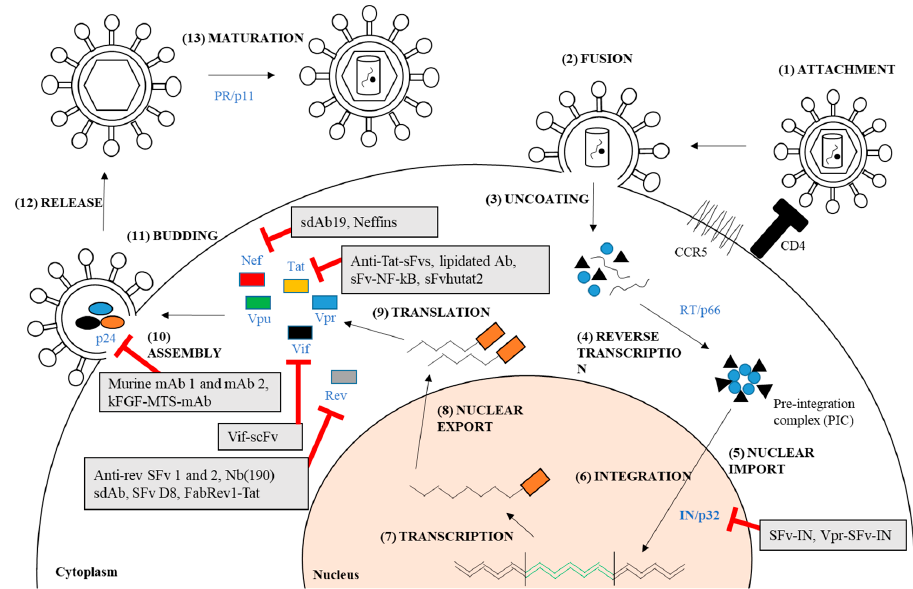
Figure 1. HIV-1 replication cycle and the antiviral targets for antibody-mediated treatment which have been previously reported. (1) The virus attaches to the cell by engaging the receptor CD4 and co-receptor CC-chemokine receptor 5 (CCR5); (2) This leads to the fusion of virus and cell